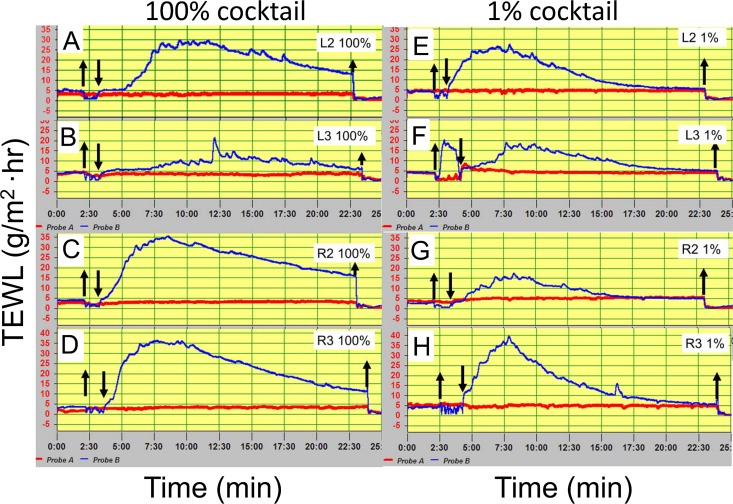
C-sweat responses of the heterozygote (EB01) to intradermal injections of 100% and 1% strength cocktail measured at 4 sites with evaporimetry.(A)-(D) show evaporimetry traces to the 100% cocktail strength at each of the 4 sites; (E)-(H) show traces to 1% cocktail. Down arrows show probes on and up arrows show probes off. Evaporimeter traces show TEWL units of 5 g/(m2·hr) (y-axis) and units of 2.5 min (x-axis).